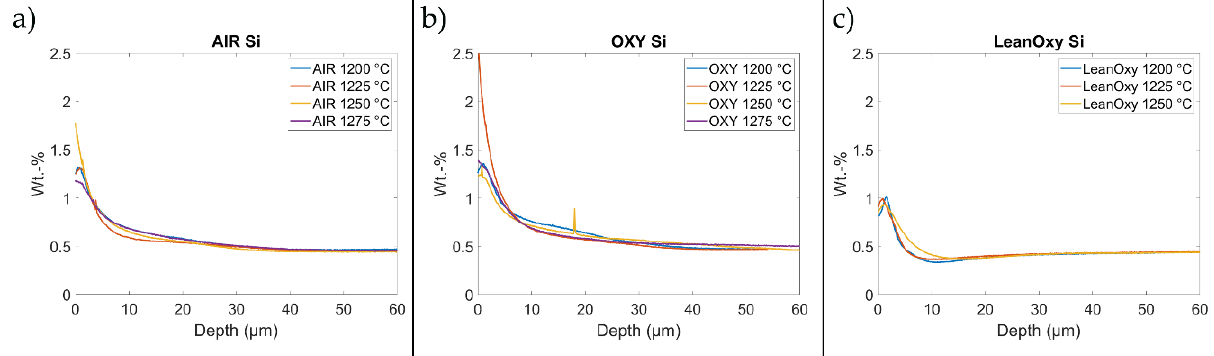
Figure 9. The individual temperature GDOES graphs for Si in ( a ) air, ( b ) oxyfuel and ( c ) lean oxyfuel atmosphere.